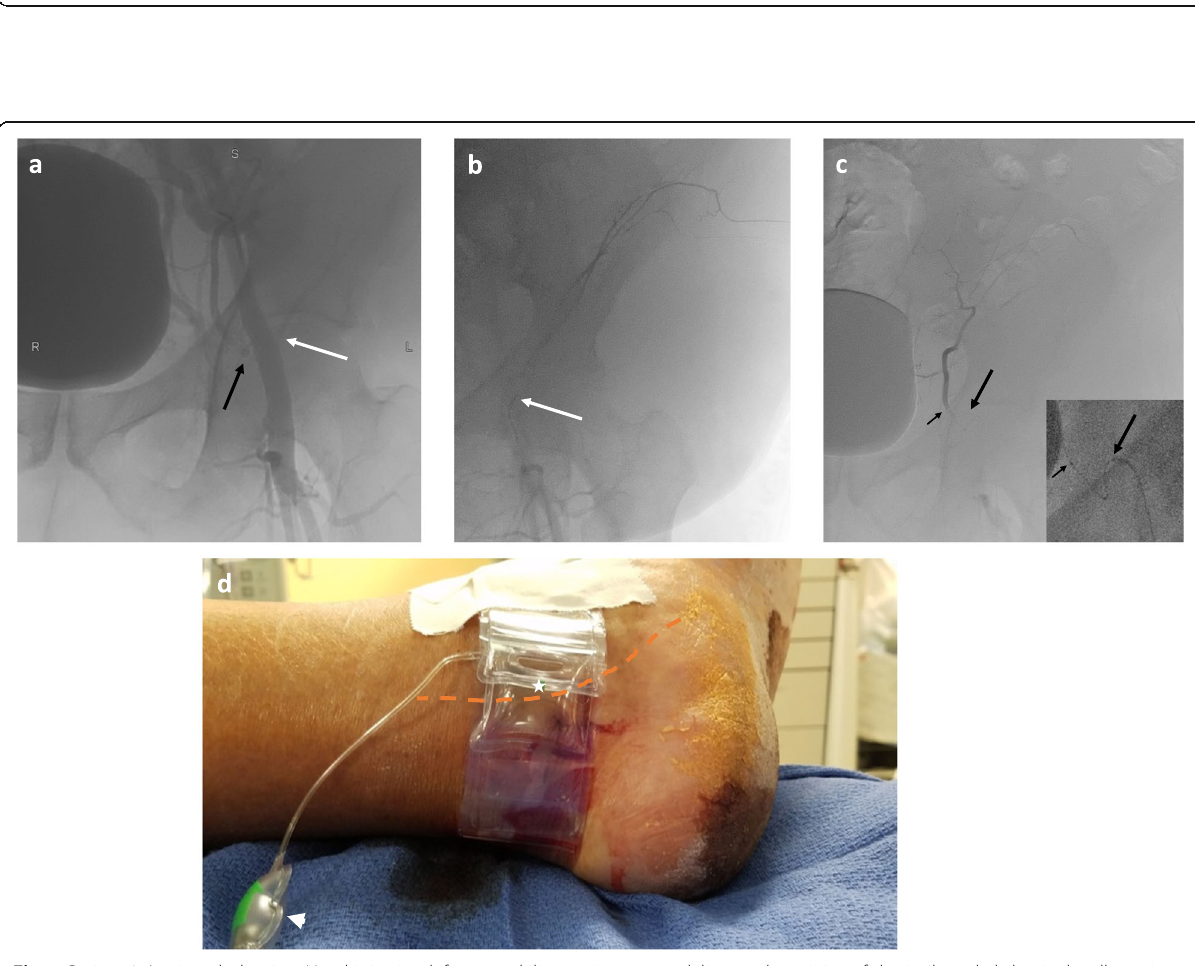
Fig. 4 Patient 2 Angioembolization: Hand injection left external iliac angiogram to delineate the origins of the ipsilateral abdominal wall arteries ( a ). Deep circumflex iliac angiogram without active extravasation, which was subsequently embolized to stasis with Gelfoam slurry ( b ). Inferior epigastric angiogram (inset shows fluoroscopic last image hold; long arrow points to base catheter, short arrow points to microcatheter) without active extravasation; this vessel was also embolized to stasis with polyvinyl alcohol particles ( c ). Hemostasis of the PTA ( − − - indicates underlying course) was achieved with a large TR band (* indicates balloon; arrowhead points to inflation port) buttressed by a single piece of cloth tape ( d